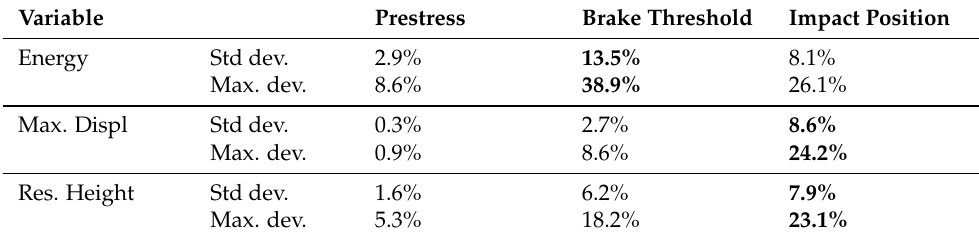
Table 11. Variability due to impact position, prestress, and brake-activation threshold uncertainties. Variable Prestress Brake Threshold